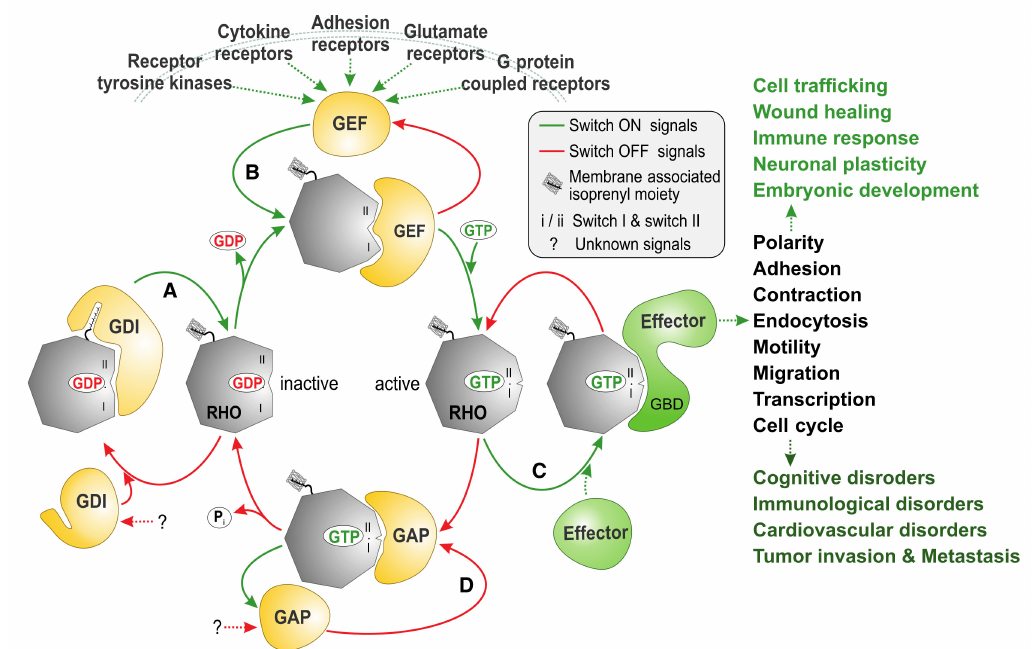
Figure 1. Molecular principles of RHO GTPase regulation and signaling. Most RHO GTPases (20 canonical human members) act as molecular switches by cycling between a GDP-bound, inactive state and a GTP-bound, active state. They interact specifically with four structurally and functionally unrelated classes of proteins: ( A ) In resting cells, guanine nucleotide dissociation inhibitors (GDIs; 4 human members) sequester RHO in the cytoplasm, away from the membrane, by binding to the lipid anchor and thus creating an inactivated cytosolic pool; ( B ) in stimulated cells, different classes of membrane receptors activate guanine nucleotide exchange factors (GEFs; 85 human members: 74 DBL and 11 DOCK family proteins), which in turn activate RHO by accelerating the intrinsic exchange of GDP for GTP and switch ON signal transduction; ( C ) active GTP-bound RHO interacts through the GTPase-binding domain (GBD) with and activates downstream targets (effectors; >70 human members) to cause a variety of intracellular pathways, which control a multitude of biochemical processes involved in the regulation of different biological (dys)functions; ( D ) GTPase-activating proteins (GAPs; 66 human members) negatively regulate RHO by stimulating its slow intrinsic GTP hydrolysis activity and switch OFF signal transduction. Notably, all RHO-interacting proteins recognize and bind RHO at consensus-binding sites called switch I and